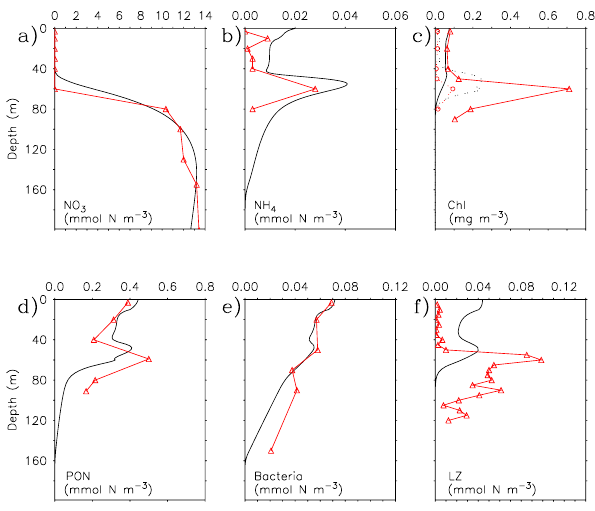
Fig. 9. Model–data comparisons (scalars) for the “constant C:Chl” run. Model outputs are in black and observations in red: (a) NO 3 , (b) NH 4 , (c) Chl for SP and LP (in the model, full and dashed lines, respectively; in the observations, triangles and circles, respectively), (d) PON (i.e., sum of LP, SP, SZ, BACT and dPON in the model), (e) biomass of bacteria and (f) LZ.